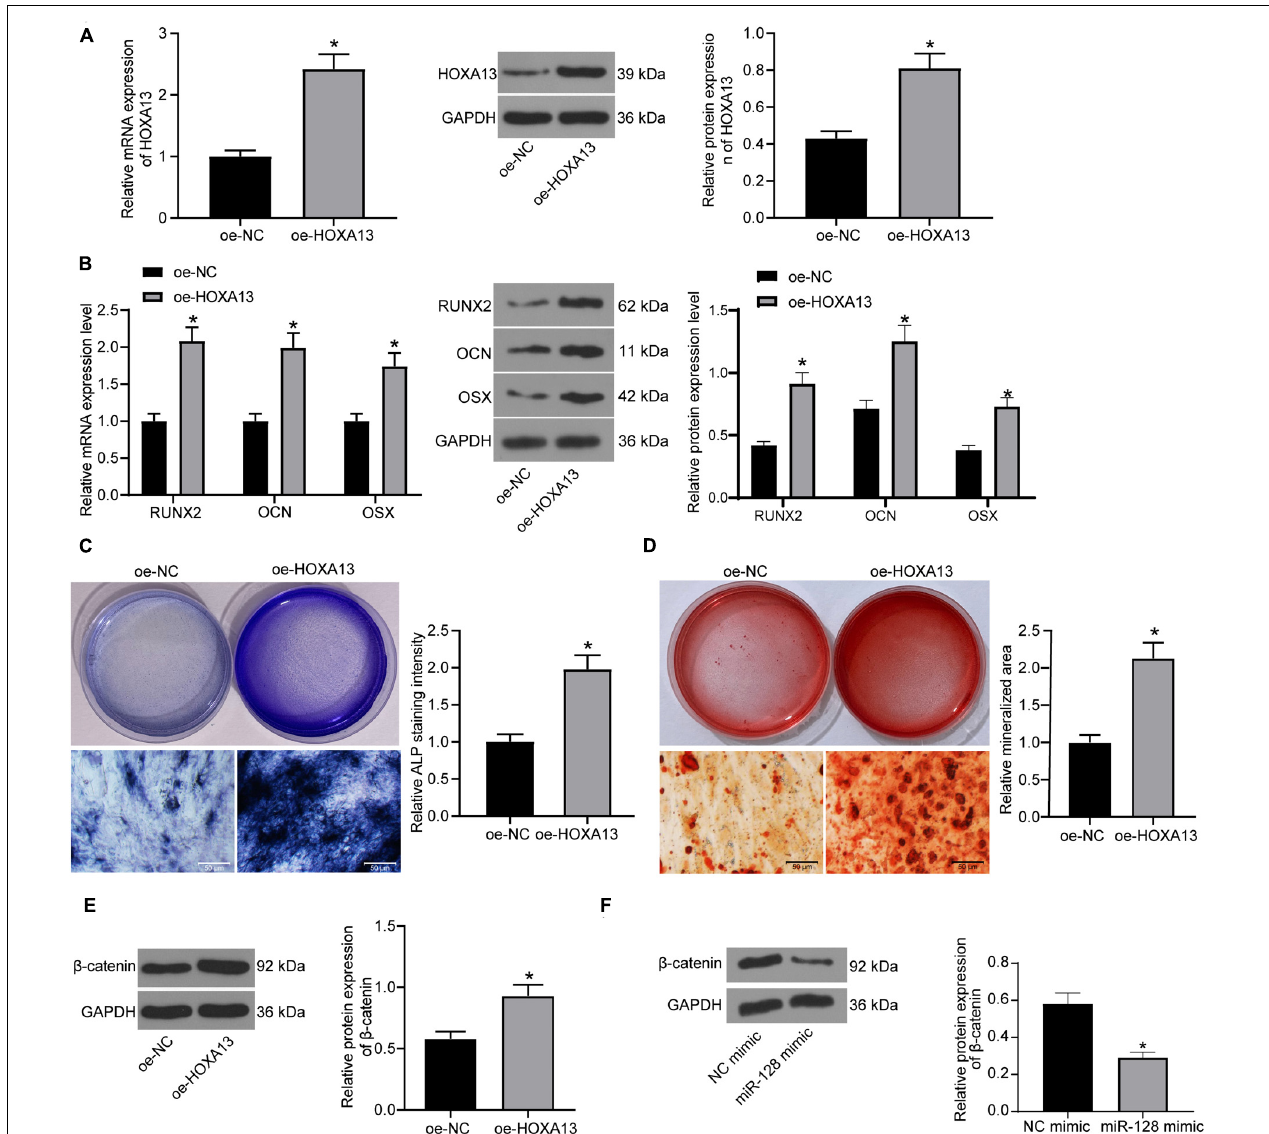
FIGURE 6 | HOXA13 promotes osteogenic differentiation ability of MC3T3-E1 cells. (A) Transfection efficacy of oe-HOXA13 determined by RT-qPCR and western blot analysis (unpaired t -test, * p < 0.05). (B) mRNA and protein expression of RUNX2, OCN and OSX in cells on day 7 determined by RT-qPCR and western blot analysis, respectively (two-way ANOVA, * p < 0.05). (C) ALP concentration in cells measured by ALP staining (unpaired t -test, * p < 0.05). (D) Calcareous accumulation in cells on day 21 evaluated by ARS staining (unpaired t -test, * p < 0.05). (E,F) Protein level of β -catenin in cells after HOXA13 (E) or miR-128 (F) overexpression determined by western blot analysis (unpaired t -test, * p <